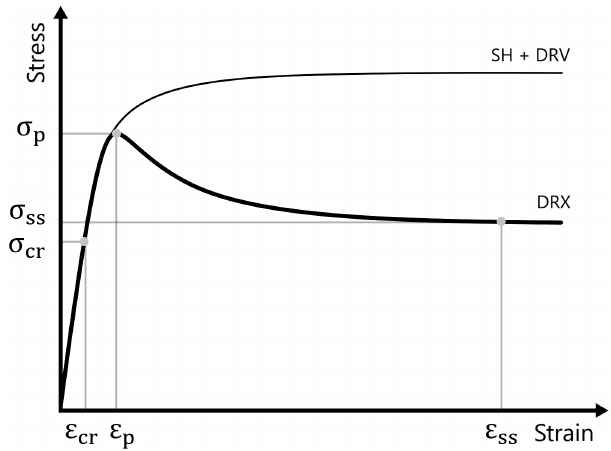
Figure 1. Flow curve illustrating the characteristic points; peak stress/strain ( σ p / ε p ), critical stress/strain ( σ cr / ε cr ) and steady state stress/strain ( σ ss / ε ss ). The thin line represents the modelled flow curve due to strain hardening (SH) and dynamic recovery (DRV). The thick line represents the modelled flow curve with dynamic recrystallization (DRX) kinetics included.